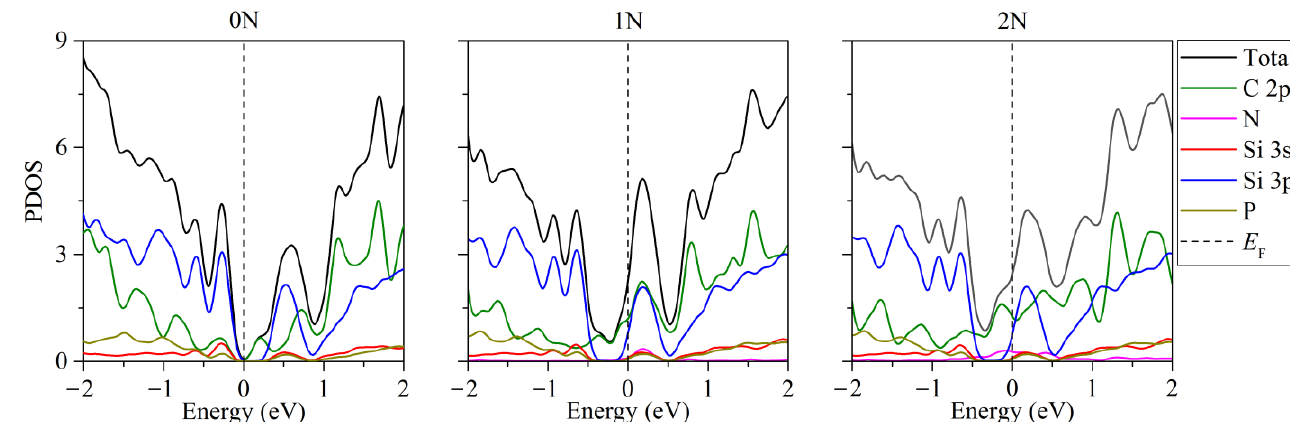
Figure 6. Partial densities of electronic states of doped systems “two-layer silicene/graphite substrate” in the presence of 2 P atoms in silicene. Reprinted with permission from Ref. [46]. 2020, Springer.